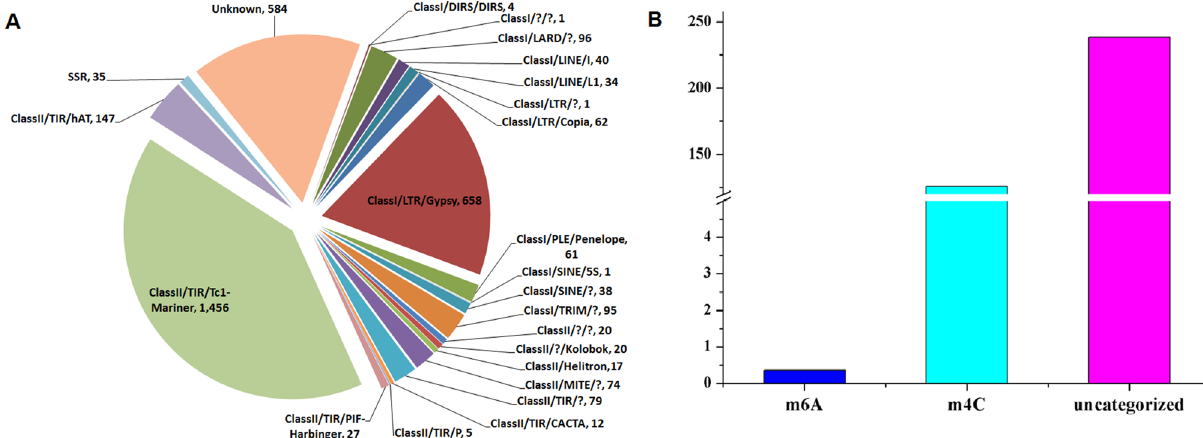
Figure 2. Statistical analysis of repeat sequences and DNA methylation in Sc. genome. ( A ) The percentage of different types of repeat sequences in the Sc. genome. ( B ) Statistical analysis of the methylation sites of candidate DNA in the main sequence of Sc. genome, where m4C and m6A represent 4-methyl cytosine and 6-methyl adenosine, respectively.